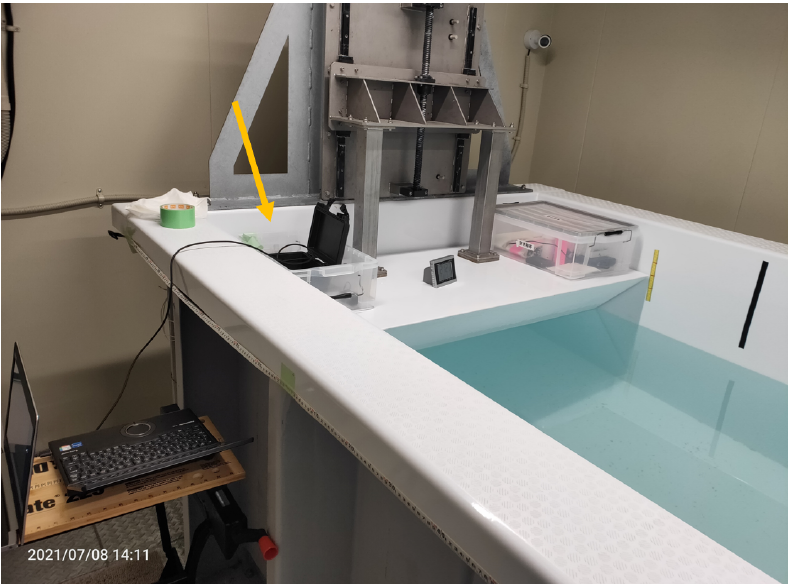
Figure 4. Illustration of the wavemaker experiment setup in the wave–ice tank of JAMSTEC (Japan Agency for Marine-Earth Science and Technology) at the Kashiwa campus of the University of Tokyo, Japan. The instrument v2021 location is shown by the yellow